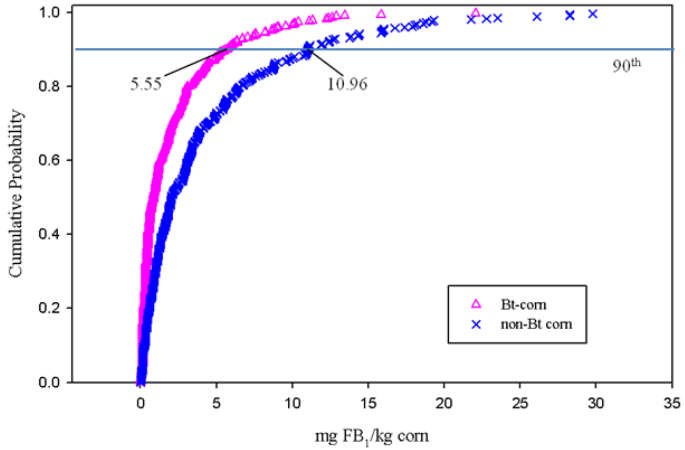
Figure 1. Cumulative distribution of fumonisin B corn) in Bt ( Bacillius thuringiensis ) vs. non-Bt corn; data from 1999 to 2006 [11-21] from Delgado and Wolt [4].